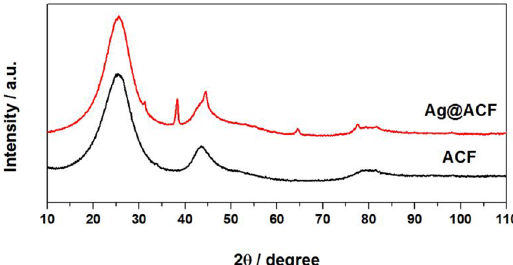
Figure 2. X-Ray diffractogram for ACF and Ag@ACF